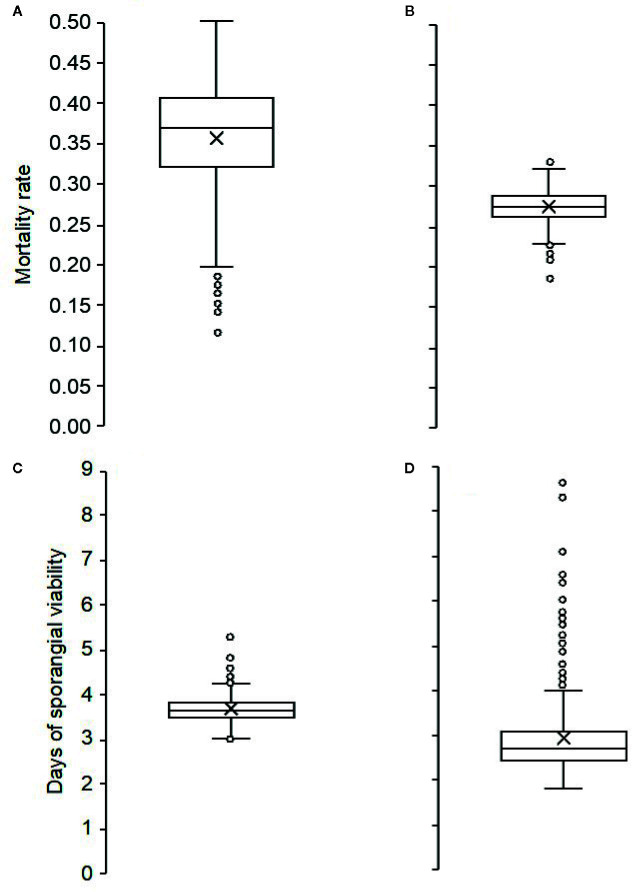
Box plots showing the distribution of: (i) the mortality rates of Plasmopara viticola sporangia attached to (A) and detached from (B) sporangiophores; (ii) numbers of days in which the sporangia attached to sporangiophores (C), or detached from sporangiophores (D) remained viable. The horizontal line in the boxes indicates the median; the box includes the 1st and 3rd quartile; dots are outliers.